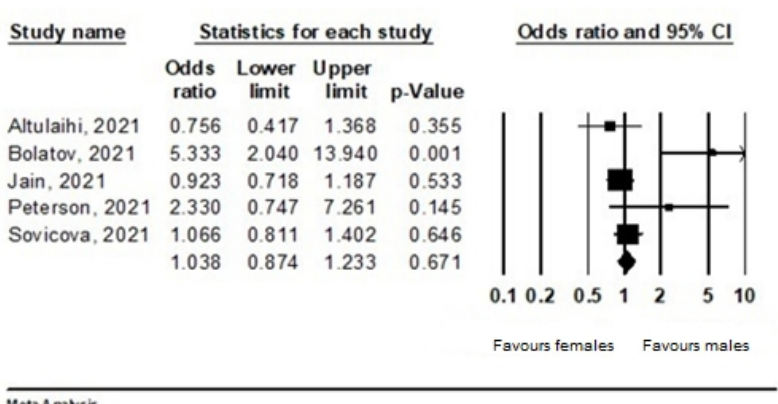
Figure 3. Forest plot representing the relationship between vaccination acceptance and gender.